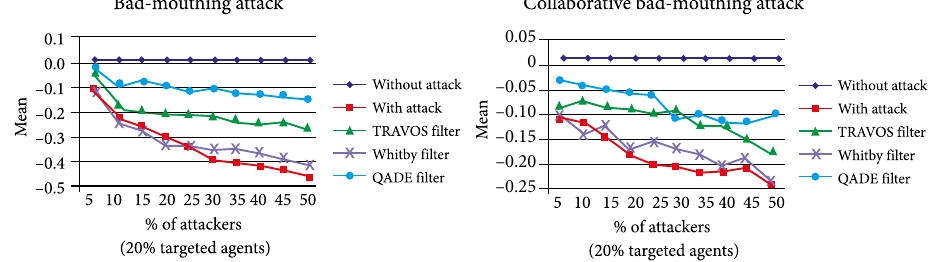
Fig. 3. The mean trust value in the “Bad-mouthing attack” configurations with different number of